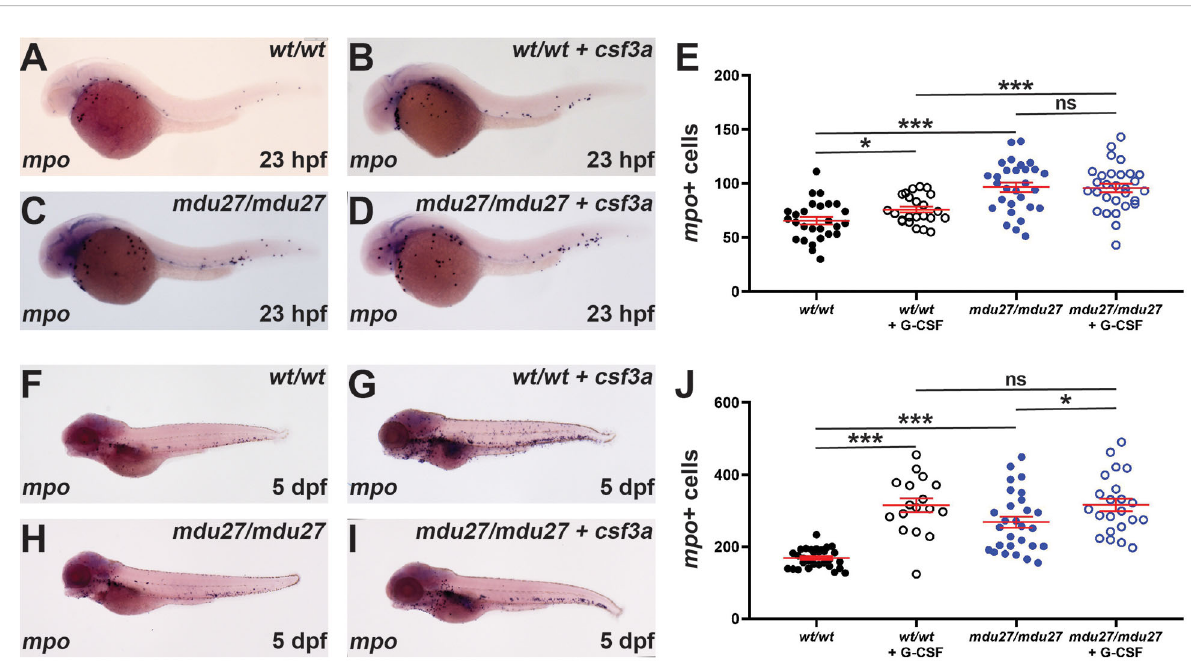
FIGURE 5 EffectofG-CSFRtruncationmutationonemergencyhematopoiesis.Wild-type( wt/wt )andhomozygous( mdu27/mdu27 )mutant csf3r embryos,either uninjectedorinjectedwithmRNAencodingG-CSF(+ csf3a )weresubjectedtoWISHwith mpo duringprimitive (A – D) andearlyde fi nitive (F – I) hematopoiesis, withrepresentativeimagesshown.Individualembryoswereassessedforthenumberof mpo +cellsforprimitive (E) andde fi nitive (J) hematopoiesis,withmean andSEMshowninredandlevelofstatisticalsigni fi canceindicated(***: p <0.001,*: p <0.05,ns:notsigni fi